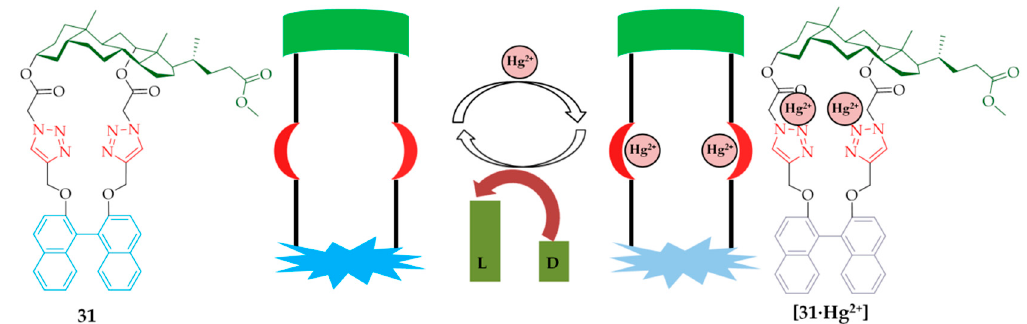
Figure 8. Schematic representation of the recognition behavior of 31 for Hg 2 + ion and its applications in cascade enantioselective recognition of amino acids.